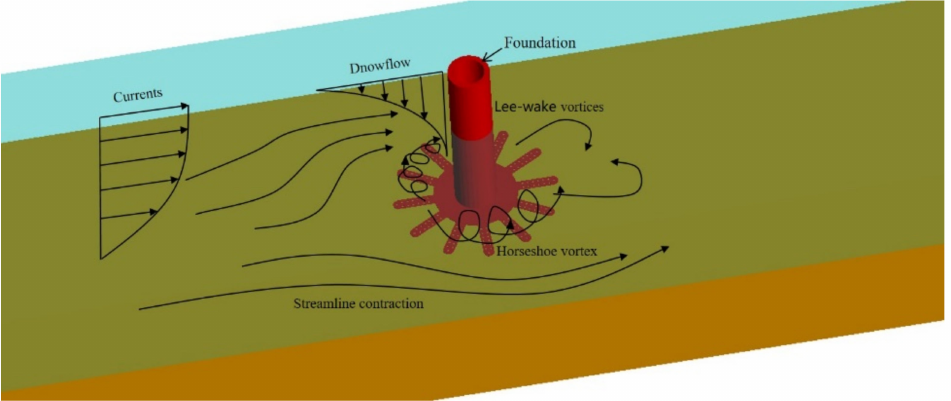
Figure 11. Sketch of scour mechanism around USAF under random